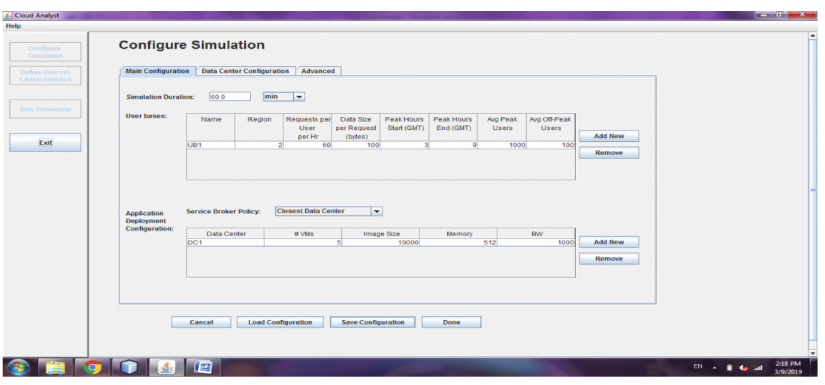
Figure 6: Data Center Adding